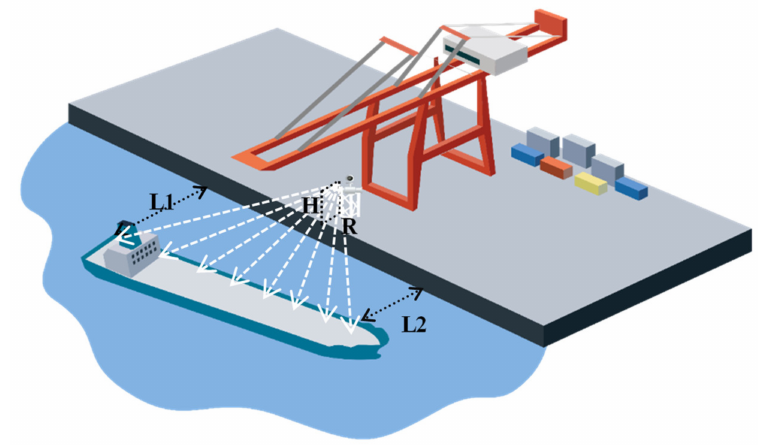
Figure 2. Three-dimensional LiDAR monitoring